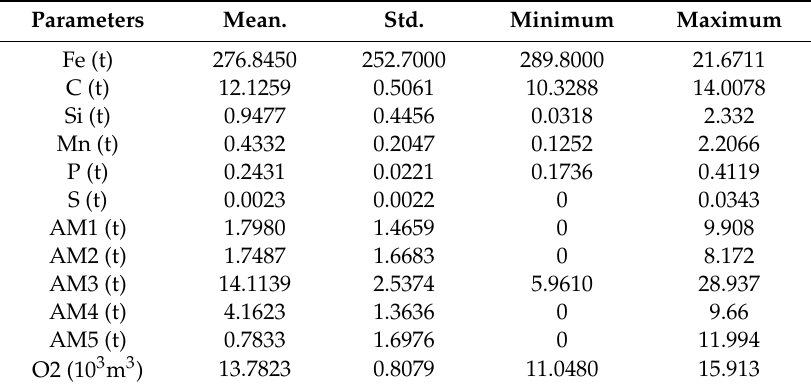
Figure 3. Oxygen consumption of each process in converters. Table 1. Descriptive statistics of data set.